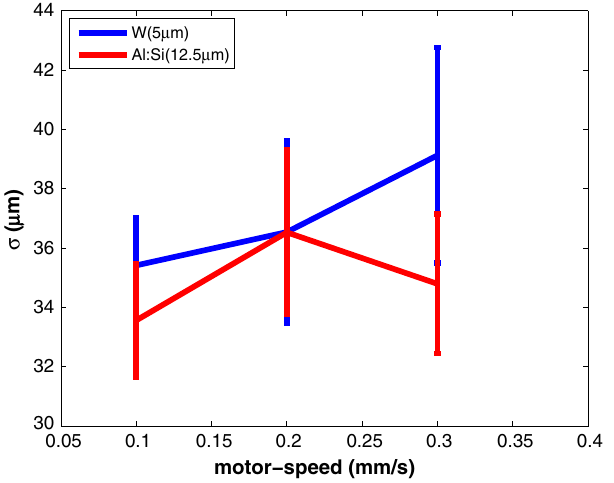
FIG. 17. Beam size measurements resulting from a wire-scan of the FERMI electron beam performed with two homologous 12 . 5 μ m Al ð 99 Þ ∶ Si ð 1 Þ and a 5 μ m W wires. During the meas- urement, the FERMI machine was set at stable and fixed beam conditions: 1.325 GeV, 700 pC and 10 Hz repetition rate. The WSC measurements of the beam profile were repeated for different motor-speeds: 0.1, 0.2 and 0 . 3 mm = s. released along the undulator chain of FERMI FEL1 was also observed at motor-speeds of 0.1 and 0 . 3 mm = s as shown in Table III where the ratio — W against Al ð 99 Þ ∶ Si ð 1 Þ — of the absolute values of the radiation-dose rate measured by the 8 I-Cs are shown together with analogous results obtained from the other beam loss monitors. Finally, the radiation-dose rate measured by the 8 I-Cs during the scan of the electron